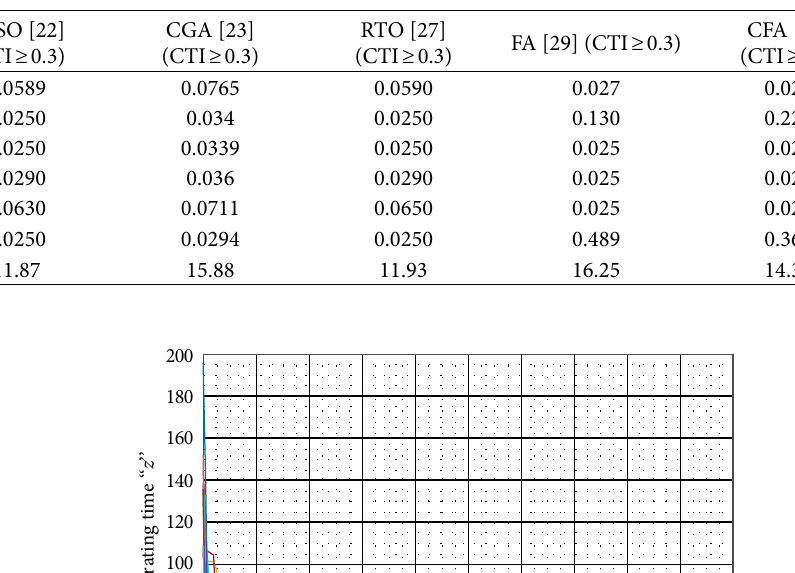
Table 5: Optimal TMS values for Case 1.